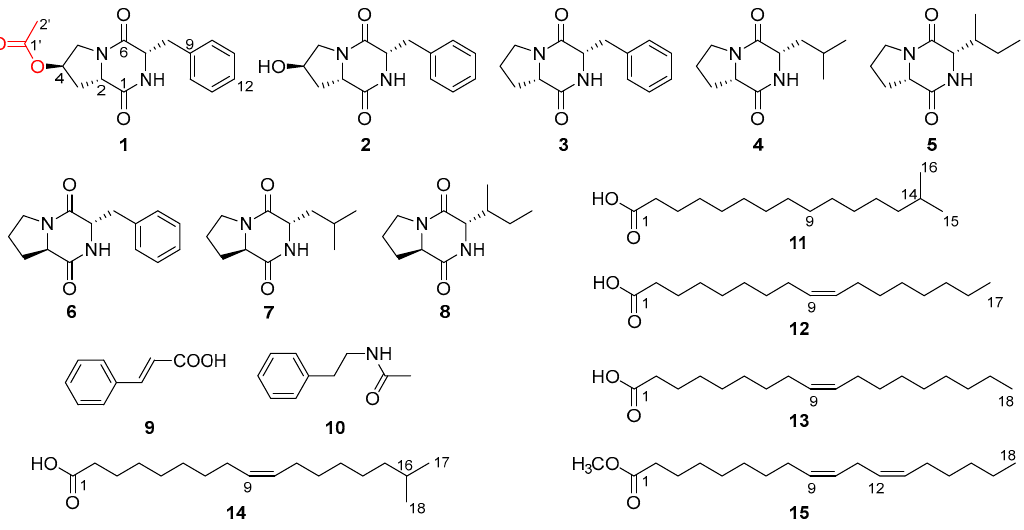
Figure 1. The chemical structures of compounds 1 – 15 .